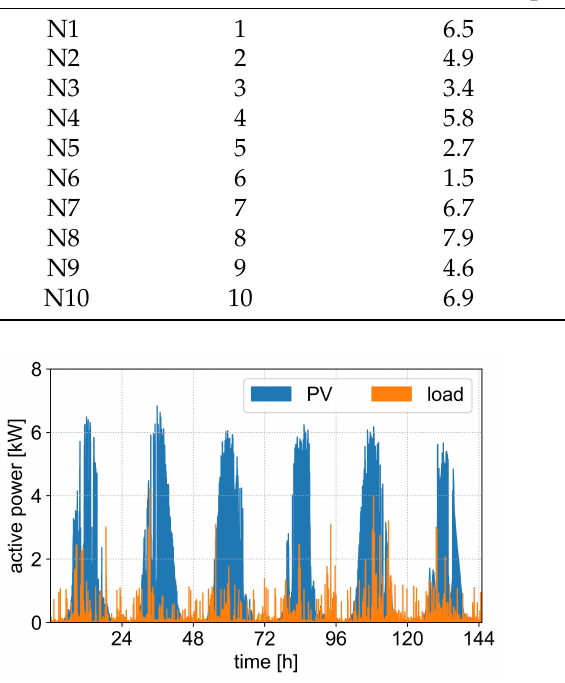
Figure 3. Load and PV profile at node N10.